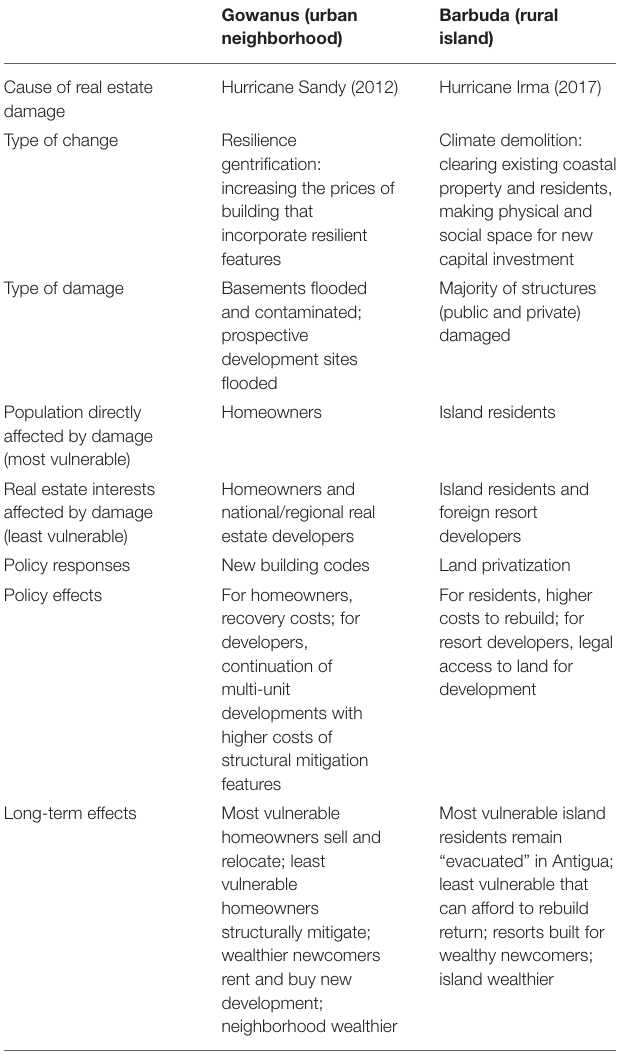
TABLE 1 | Case comparison: Gowanus and